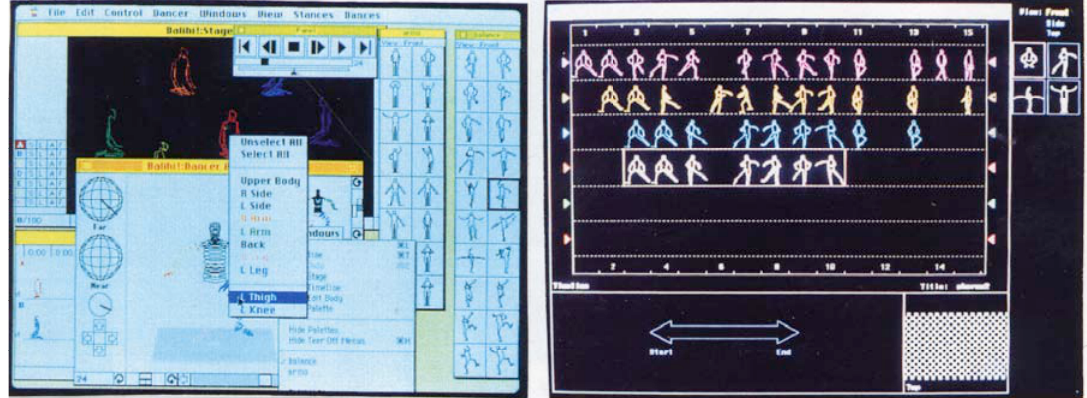
Figure 3.2a. Macintosh Stance Based